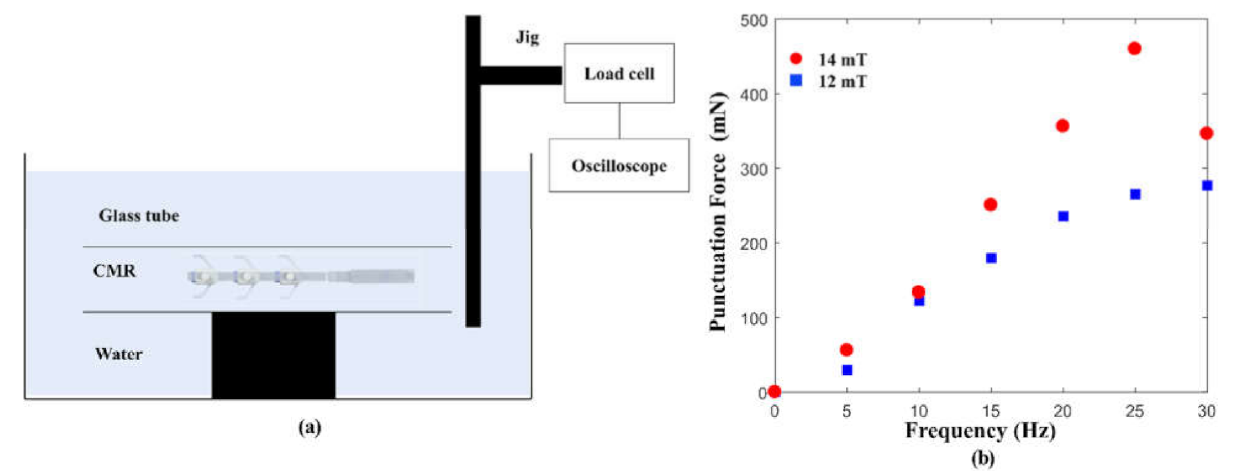
Figure 9. ( a ) Experimental setup to measure the puncturing force of CMR. ( b ) Puncturing force of CMR according to frequency and external magnetic